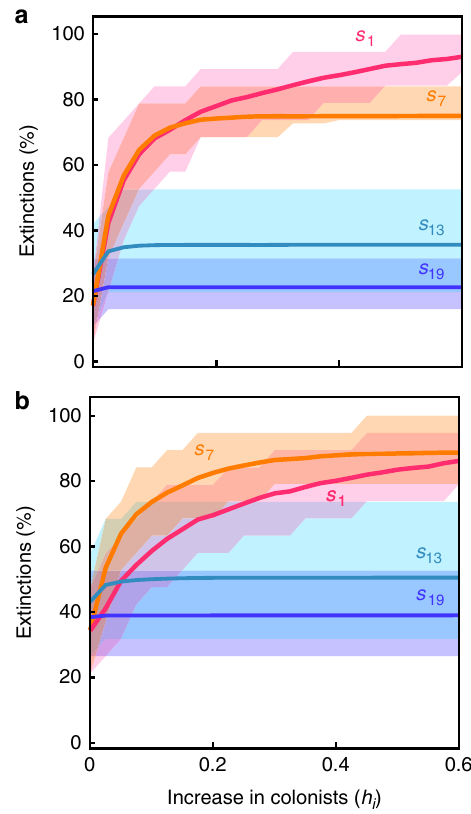
Fig. 3 Native species extinctions resulting from elevated disturbance and invasion of a species with a supply of external colonists ( h i ). Disturbance increases the mortality rate of all 20 species in the metacommunity from 0.05 to a 0.06, and b 0.35. Other details as in Fig. 2. In all panels, species are lost from the metacommunity due to increased disturbance alone (i.e. when h i = 0). Invasion of s 7 causes more extinctions than s 1 under high disturbance (shown in b ) because the natural colonisation rate of s 1 ( c 1 ) is too low to cope with elevated mortality, unless increases in h 1 compensate for